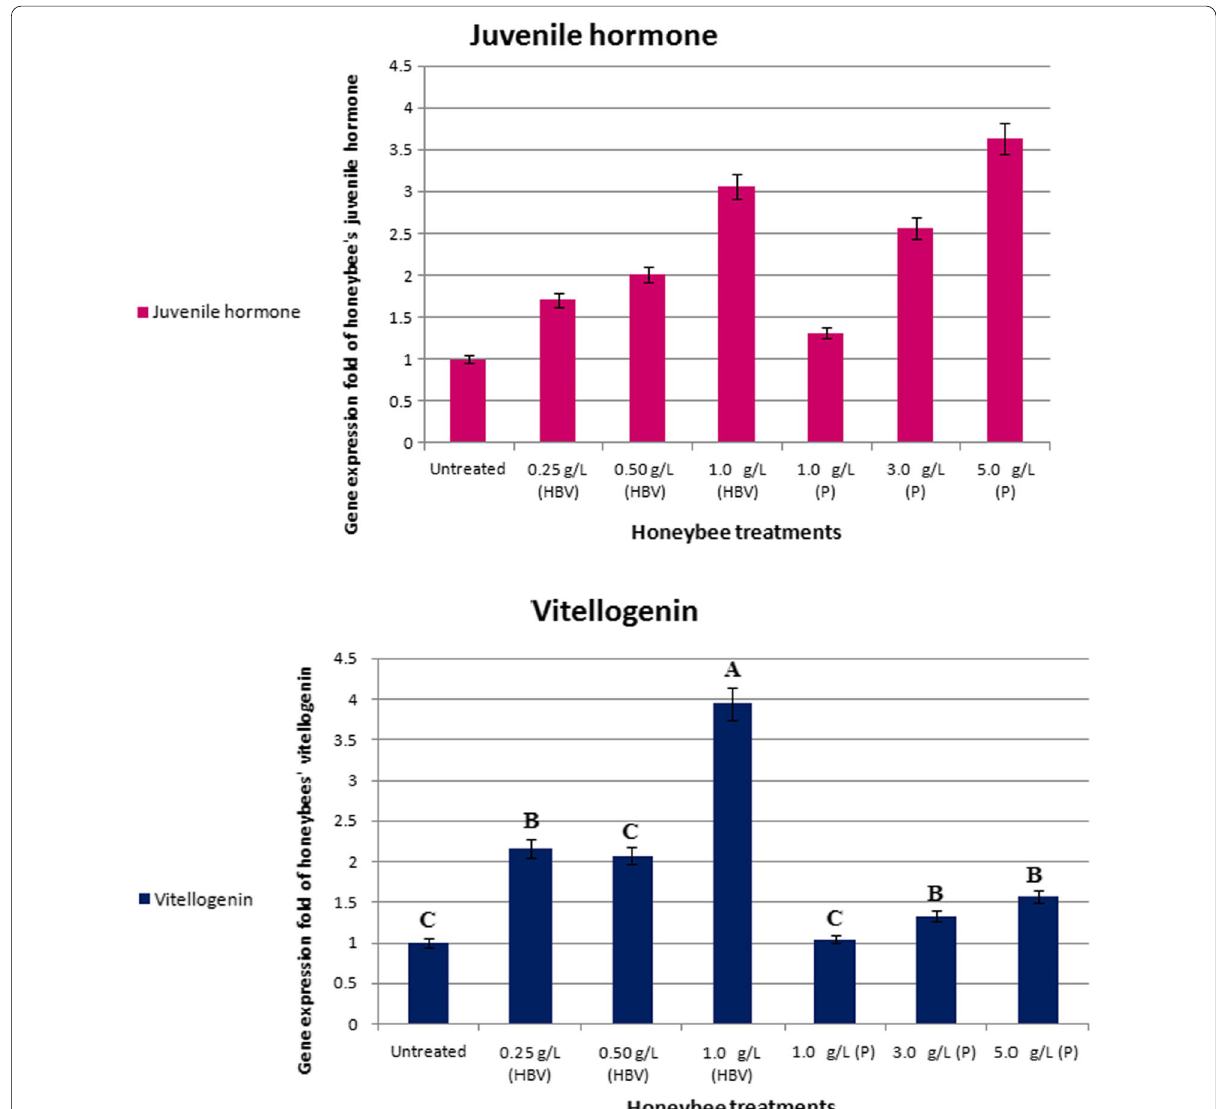
Fig. 4 a The effect of honeybee venom (HBV) and Egyptian propolis ethanolic extract (EP) in different concentrations on the expression folds of juvenile hormone esterase (JHE) for honeybee with SE performed in triplicate. b The effect of honeybee venom (HBV) and Egyptian propolis ± ethanolic extract (EP) in different concentrations on the expression folds of vitellogenin (vg) for honeybee